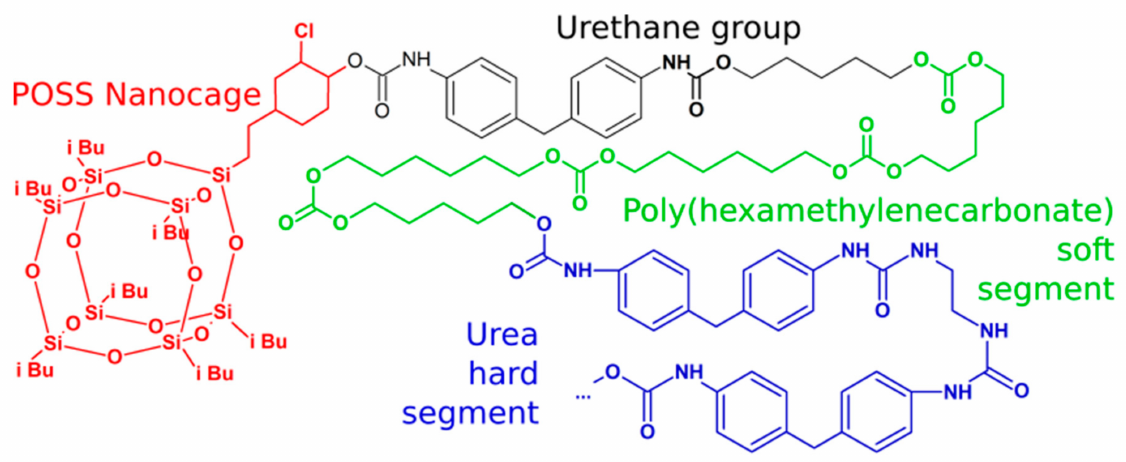
Figure 6. Structure of original PCU-POSS. Reprinted with permission from Rahmani, B.; Tzamtzis, S.; Ghanbari, H.; Burriesci, G.; Seifalian, A.M. (2012) J. Biomech.